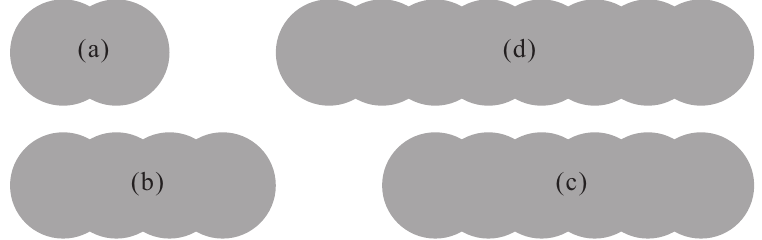
Figure 14. Clump templates used to create concrete aggregates with shape factors equal to: ( a ) 1.5; ( b ) 2.5; ( c ) 3.5; and ( d ) 4.5.